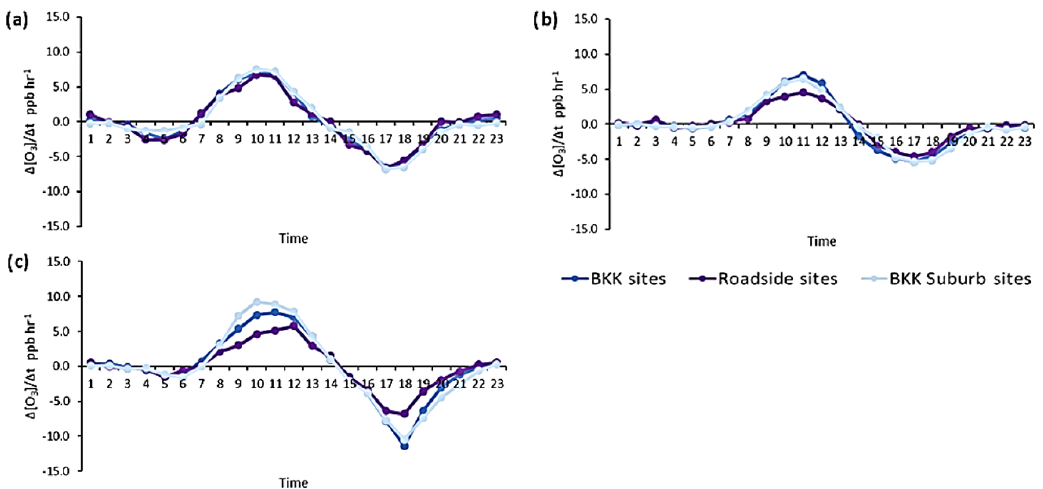
Figure 4. Diurnal variations in the rate of change in O 3 concentration ( (cid:49) [O 3 ]/d t ) during (a) local summers, (b) wet seasons and (c) local